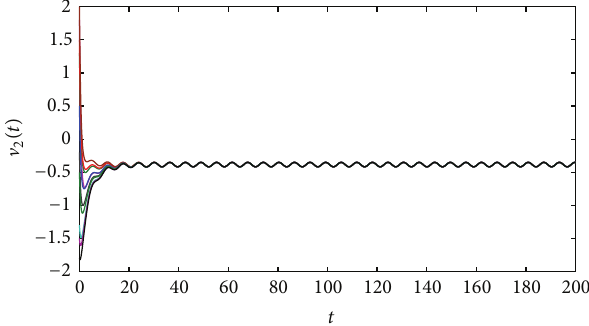
Figure 5: Transient response of state variables V 2 (𝑡) of Example 1.